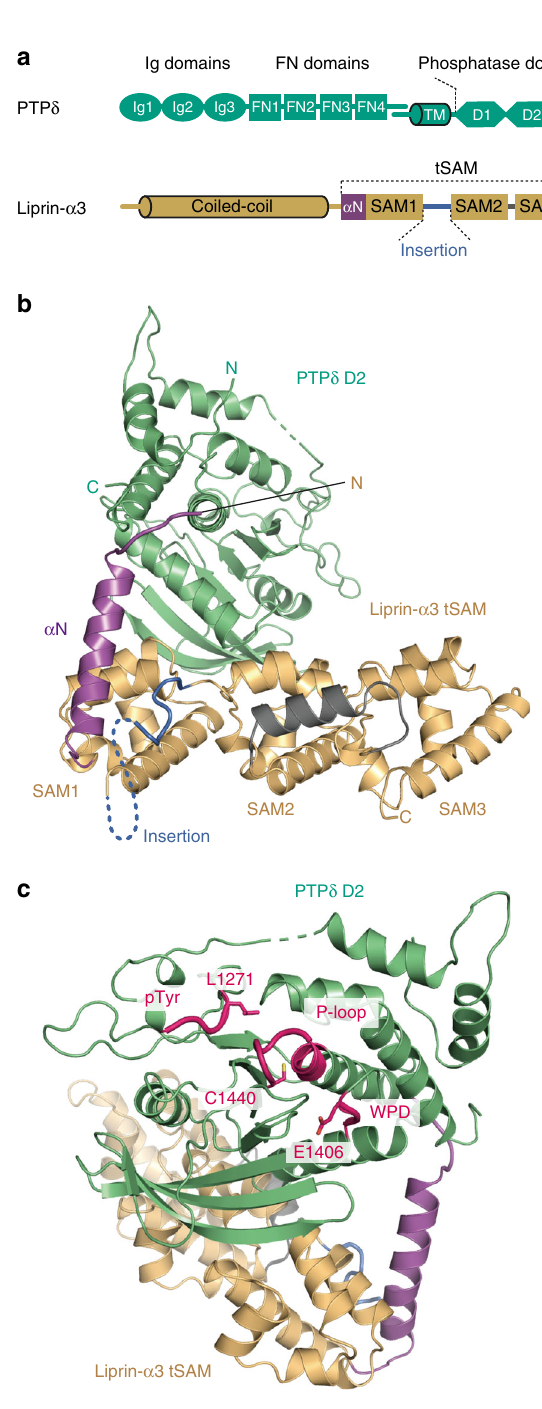
Fig. 1 Structure of the complex between PTP δ D2 and Liprin- α 3 tSAM. a Domain organizations of PTP δ and Liprin- α 3 (Ig, Immunoglobulin-like; FN, Fibronectin type III; TM, transmembrane; SAM, sterile alpha motif; tSAM, tandem SAM). b Overall structure of the complex between PTP δ D2 (green) and Liprin- α 3 tSAM ( α N, purple; SAM1 – SAM3, light brown; the insertion between SAM1 and SAM2, dark blue; the linker helix between SAM2 and SAM3, dark gray). Disordered regions are shown as dotted lines. c Pseudocatalytic site of PTP δ D2. The coloring scheme is the same as that in b , except that the pTyr, P-loop, and WPD regions are colored in